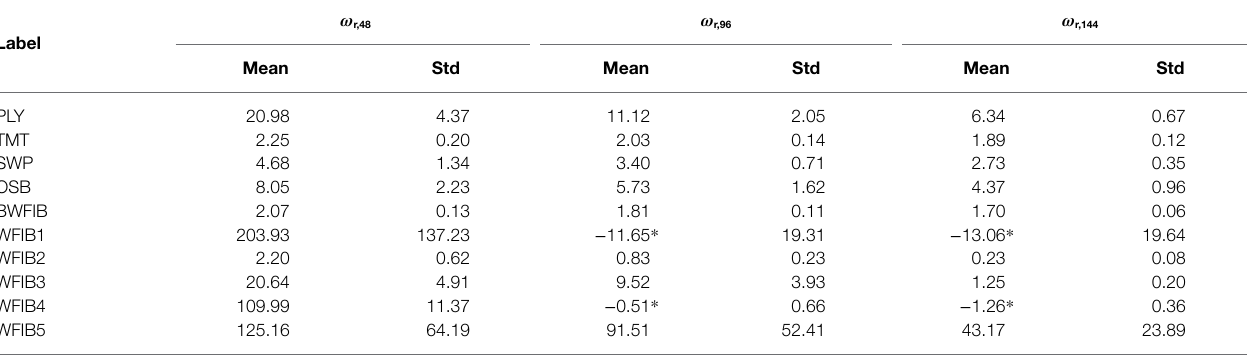
( Figure 8B ). The LFNMR relaxation time distributions indicated that water occupied smaller pores in WFIB4 as compared to WFIB1 in water-saturated state, possibly explaining the presence of this secondary absorption phase after the primary absorption phase. Also, WFIB4 was 14% less porous than WFIB1 in dry state ( Table 2 ). The lower water uptake is likely due to the smaller thickness of WFIB4 as compared the moisture concentration of WFIB4 is two times higher than WFIB1 ( Supplementary Figure 3 ).